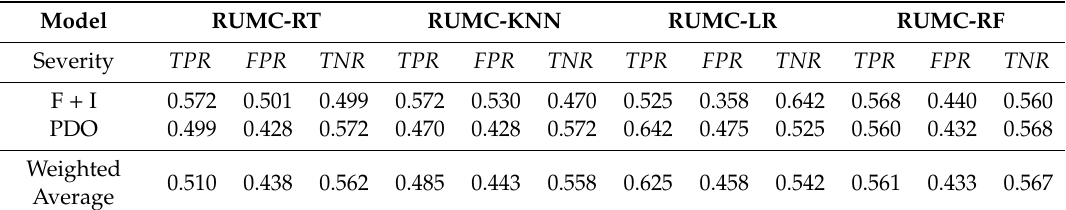
Table 6. TPR , FPR , and TNR of the classifiers with a RUMC-based training